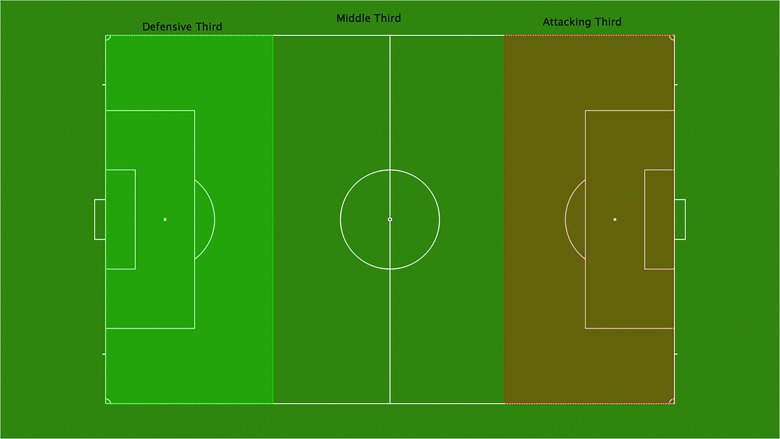
Field zones used for establishing the pass length in the offensive actions of the goalkeeper.